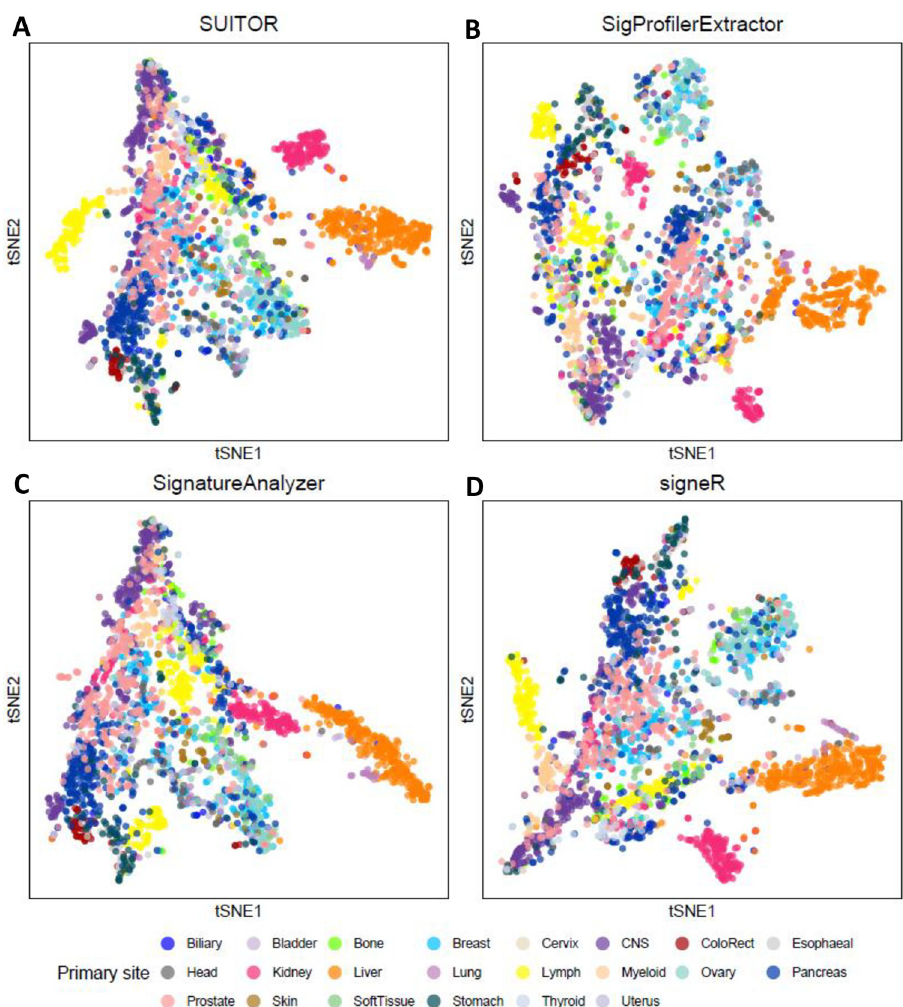
Fig 5. The t-SNE visualization of clustering patterns for 2,540 tumors across 22 cancer types based on signature activities. Signature activities are estimated by four methods: (a) SUITOR, (b) SigProfilerExtractor, (c) SignatureAnalyzer and (d) signeR. Each dot represents a tumor and is colored by the cancer